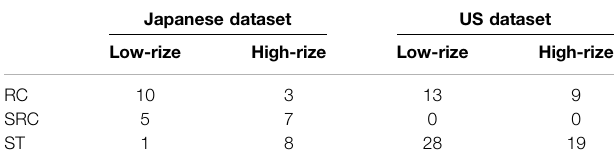
TABLE 1 | Dataset summary.